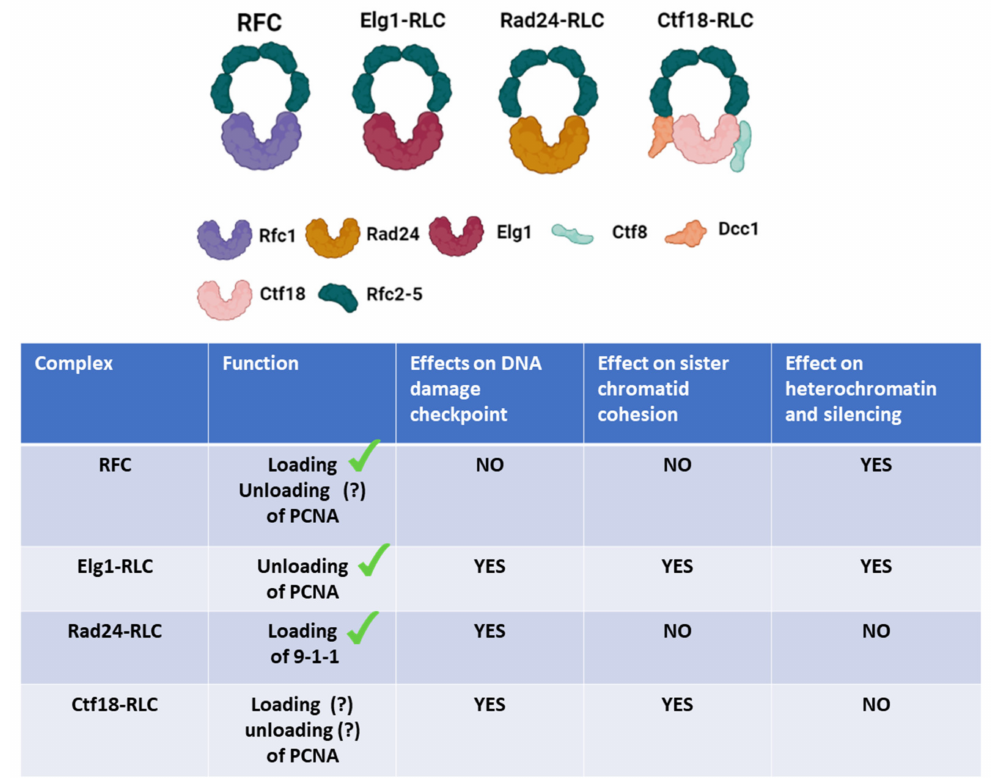
Figure 1. Schematic representation of RFC and the various RLCs : the RFC and RFC-like complexes (RLCs) are shown with a table summarizing their known functions and the cellular processes in which they take